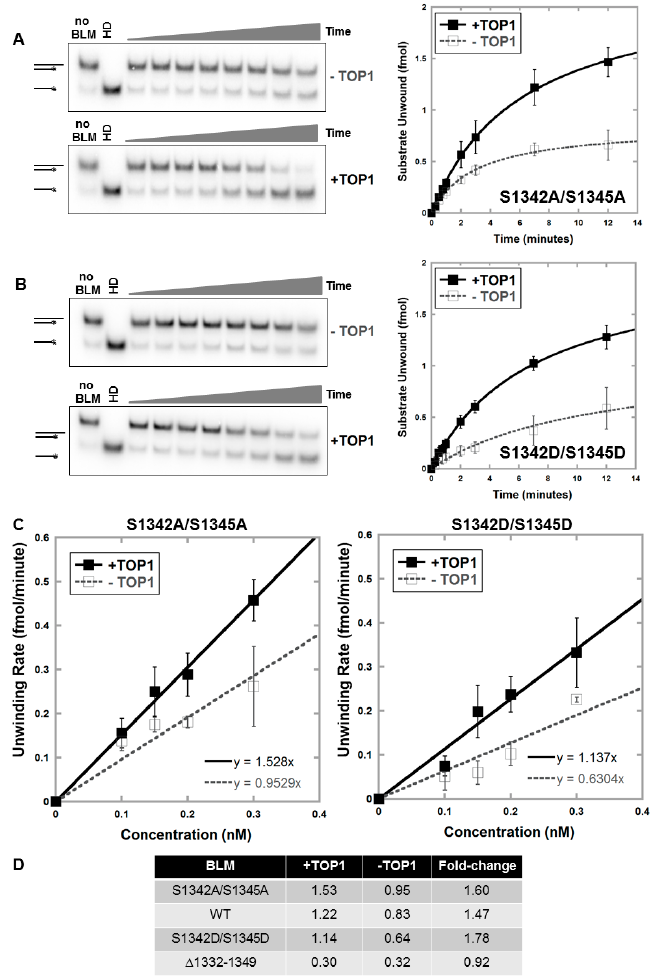
Figure 5. Unwinding of RNA:DNA substrate by BLM ‐ S1342A/S1345A or BLM ‐ S1342D/S1345D